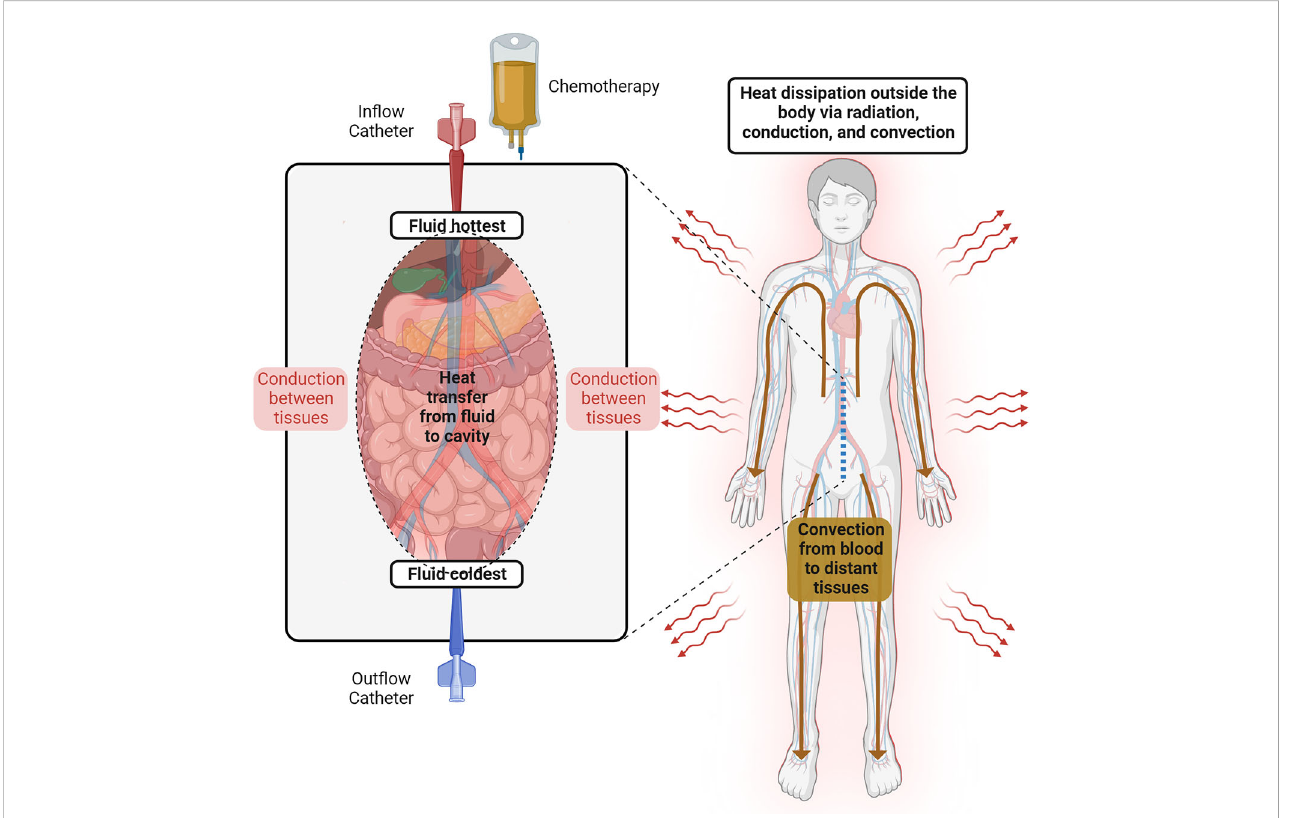
FIGURE 2 Temperature behavior during HIPEC. The heated perfusate is recirculated through the abdominal cavity. The fl uid temperature follows a gradient between the in fl ow and the out fl ow catheters. Inside the cavity, the heat is dissipated between adjacent tissue layers via conduction, while distant tissues receive heat via convection from the blood fl ow. Thermoregulatory responses to hyperthermia (e.g., vasodilatation and sweating) allow heat dissipation outside the human